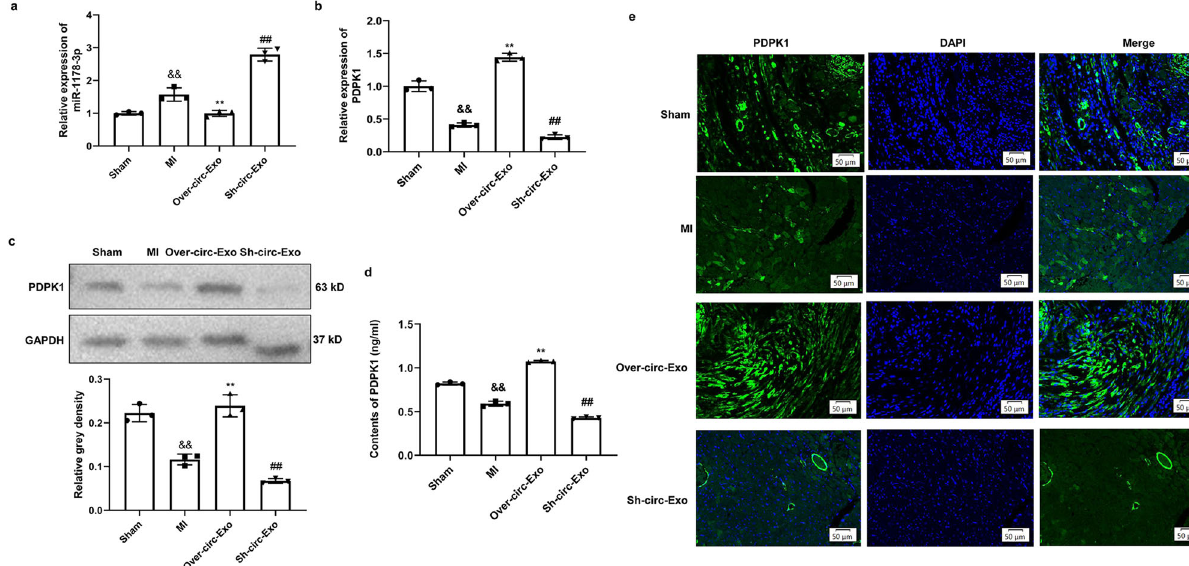
Fig. 9 Expression changes of miR-1178-3p and PDPK1 in vivo treatment with exosomes harboring circCEBPZOS. a Expression of miR-1178-3p was detected by qRT – PCR, U6 acted as a control; b , c Expression of PDPK1 was detected by qRT – PCR and western blotting. GAPDH served as control. d Immuno fl uorescence staining was used to detect the expression of PDPK1 in heart tissues. DAPI was used to stain the nuclei; Bar = 50 μ m. e ELISA was used to detect the contents of PDPK1.Data are mean ± SD. ** P < 0.01, Over-circ-Exo group vs. Model-NC group; ## P < 0.01, She-circ-Exo group vs. Model- NC